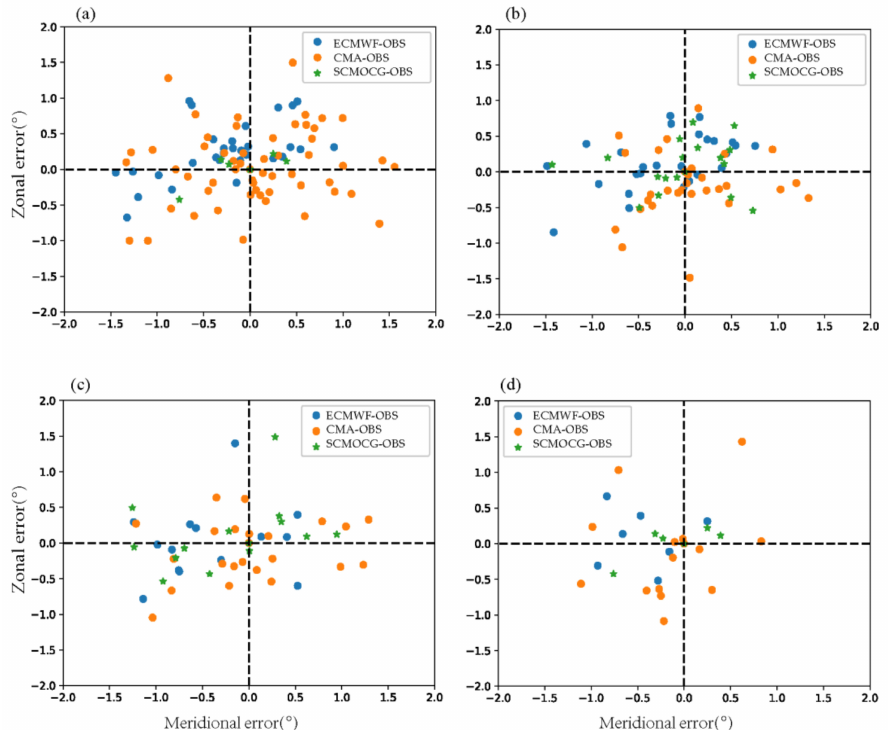
Figure 7. Spatial position errors of the matched cluster objects that are verified by the MODE method for the three precipitation forecast products under different circulation situations. ( a ) FGXFC. ( b ) XFC. ( c ) XNW. ( d )